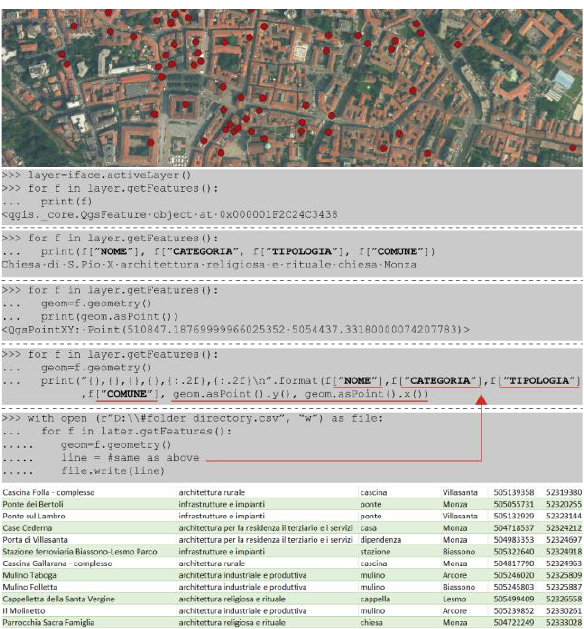
Figure 3. Code is written in PyQGIS to filter values of point features (source: Lombardian Geoportal) and add coordinates. Results were saved in external CSV format (source: D.